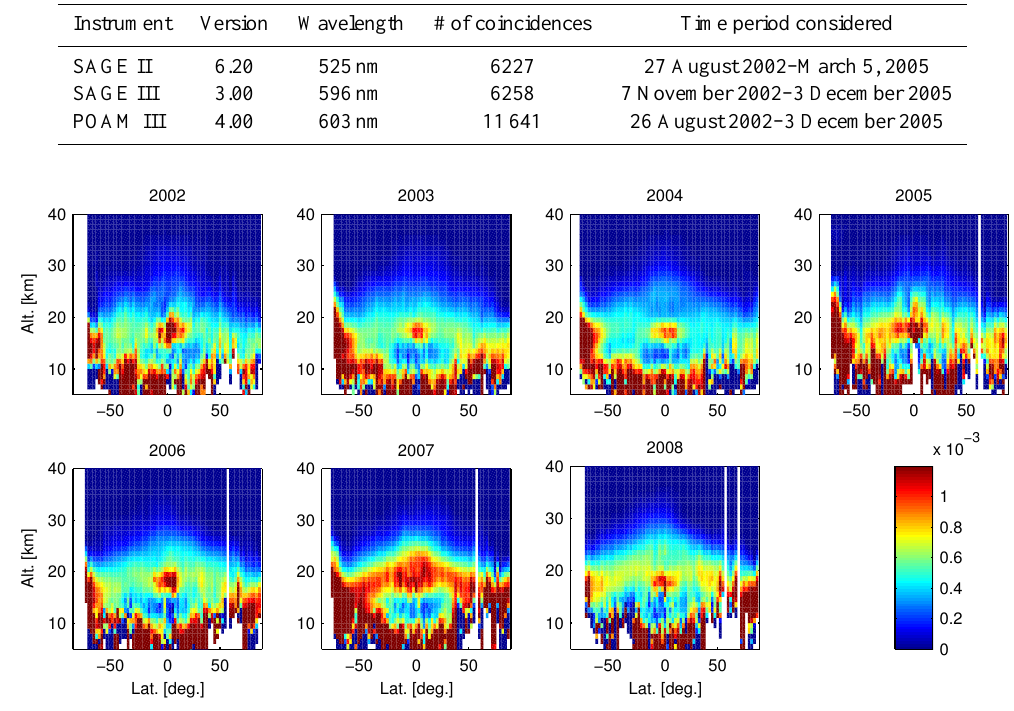
Fig. 5. Typical “on/off-events” such as clouds (tropical cir- rus, PSCs) exhibit large variability, while slowly changing features (such as the stratospheric aerosol layer) vary little within one year. Notice once again that the Antarctic PSC variability during 2002 and 2008 is weak since these years have not been completely sampled. At lower, tropospheric altitudes, we see large variability due to a combination of larger profile uncertainty (measured signals are weaker) and tropospheric